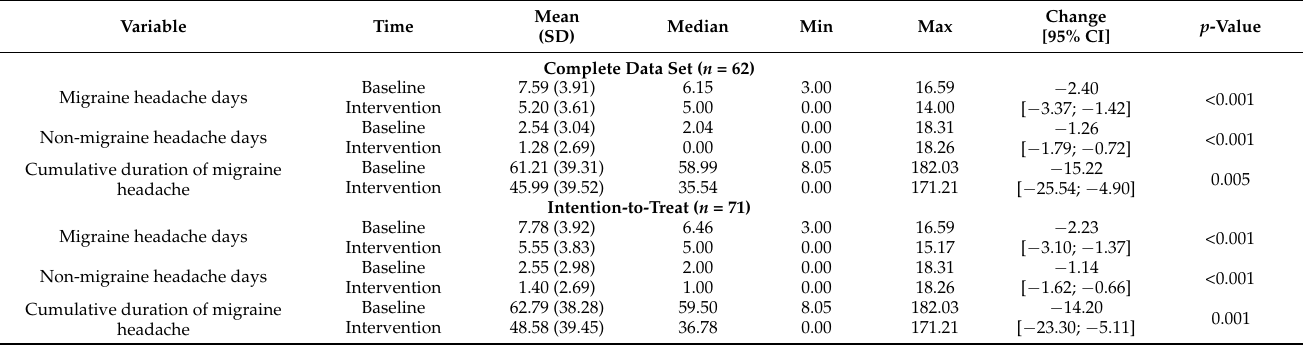
Table 2. Change in migraine headache days, non-migraine headache days, and cumulative duration of migraine headache in hours between the four-week baseline phase and last four weeks of intervention phase in the complete data set analysis ( n = 62) and in the intention-to-treat analysis ( n = 71). Data was assessed with the daily headache